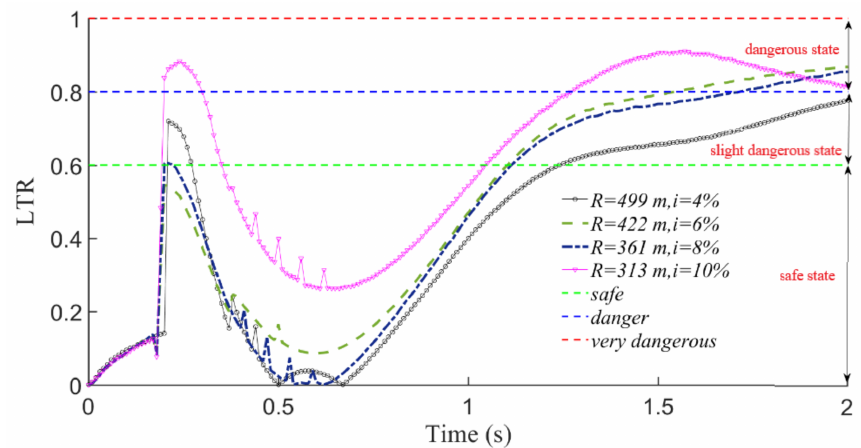
Figure 8. Simulation results of LTR at a speed of 100 km/h before collision.